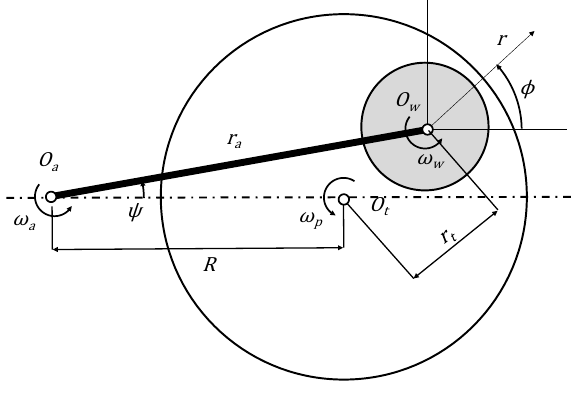
Fig. 3. Kinematics of the polishing mechanism.